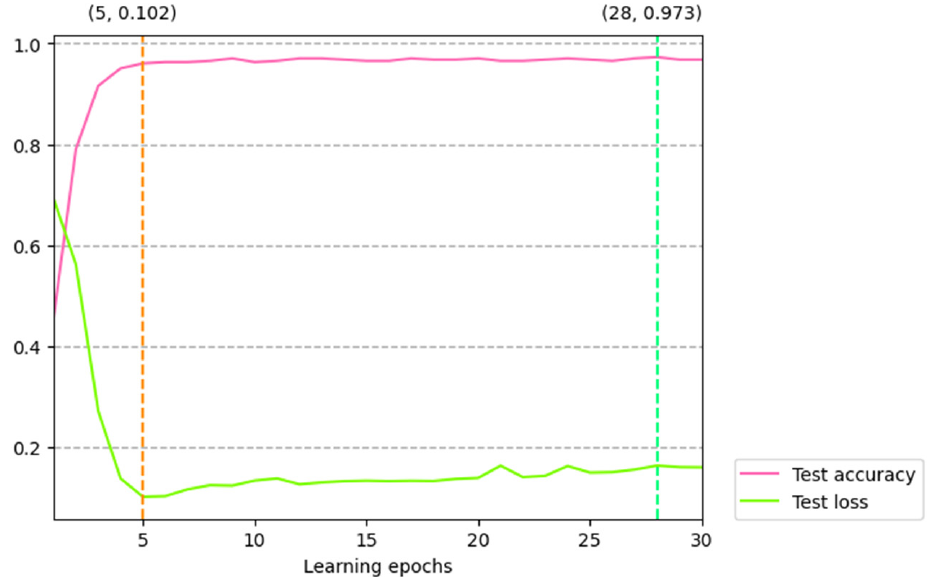
Figure 6. The test accuracy and test loss value change with the learning epochs. The value at the top of the spring green dashed line represents the learning epoch with the maximum test accuracy and its corresponding accuracy, and the value at the top of the lawn green dashed line represents the learning epoch with the minimum test loss and its corresponding test loss value.